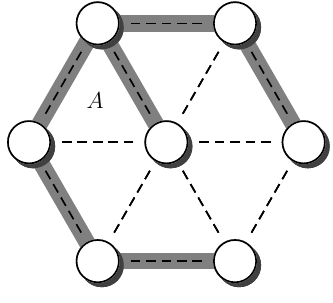
Figure 1. A Spanning tree A over a graph G Figure 1: A Spanning tree A over a graph G .